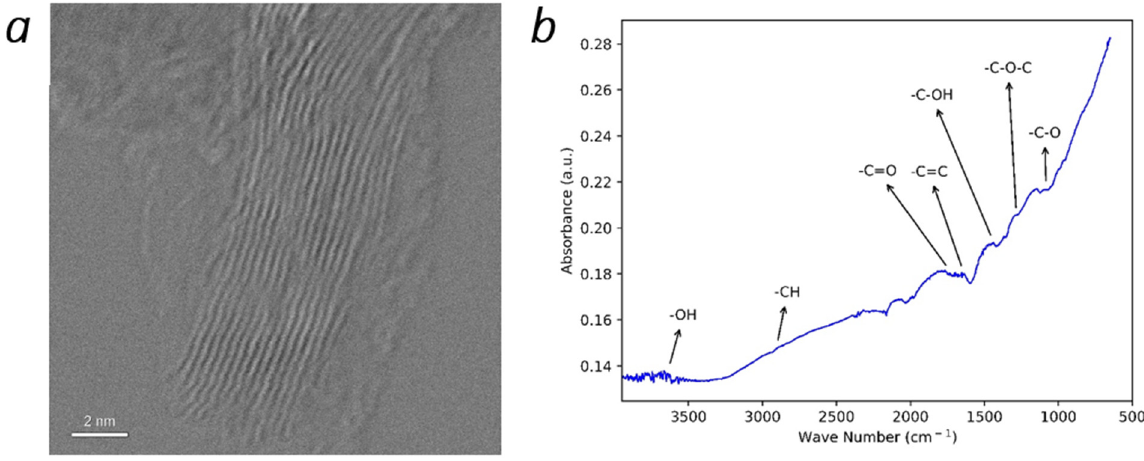
Figure 4. ( a ) TEM image and ( b ) FTIR spectra of the synthesized multilayer graphene .